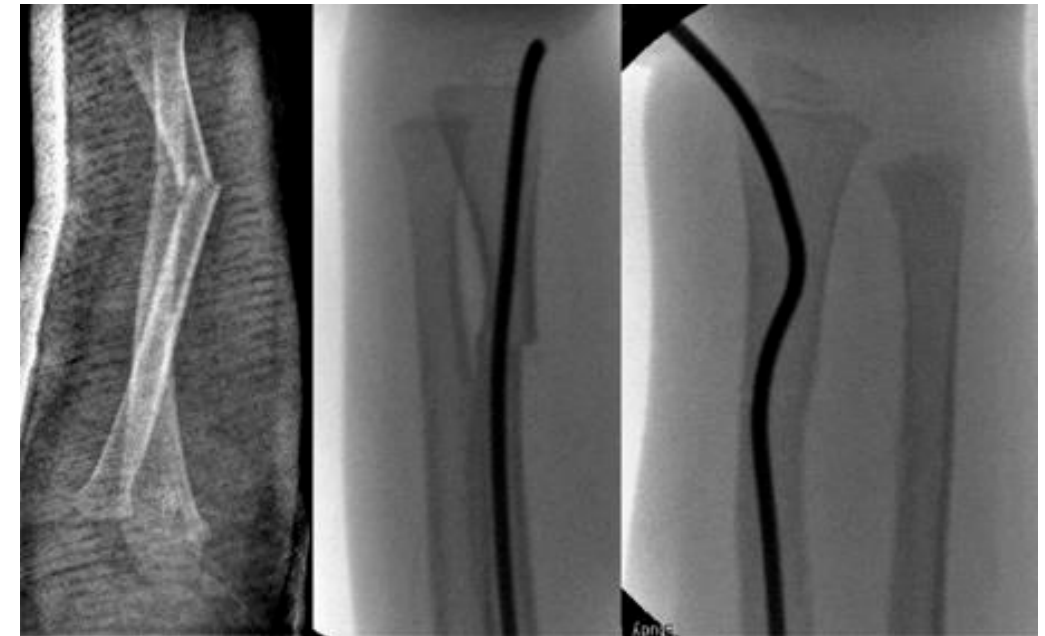
Scheme 2. 2-year-old boy with secondary displacement.